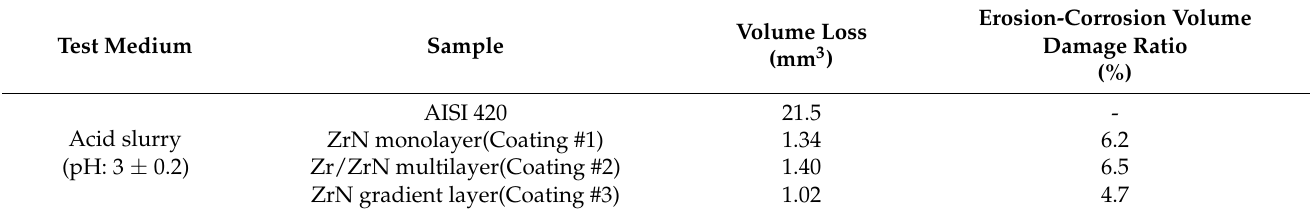
Table 2. Erosion-corrosion results of AISI420 steel with and without coatings.